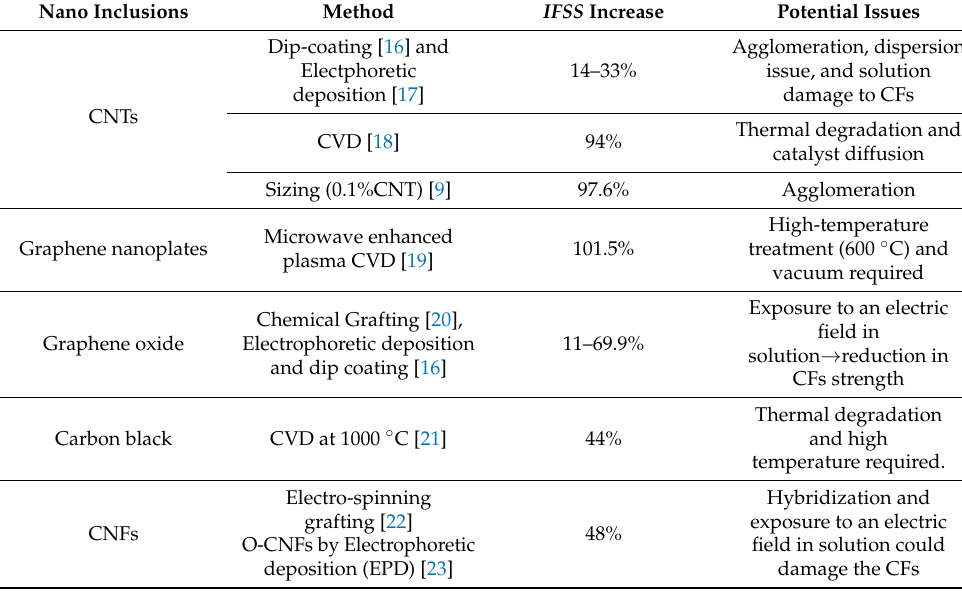
Table 3. Carbonaceous materials coated CFs to enhance their IFSS